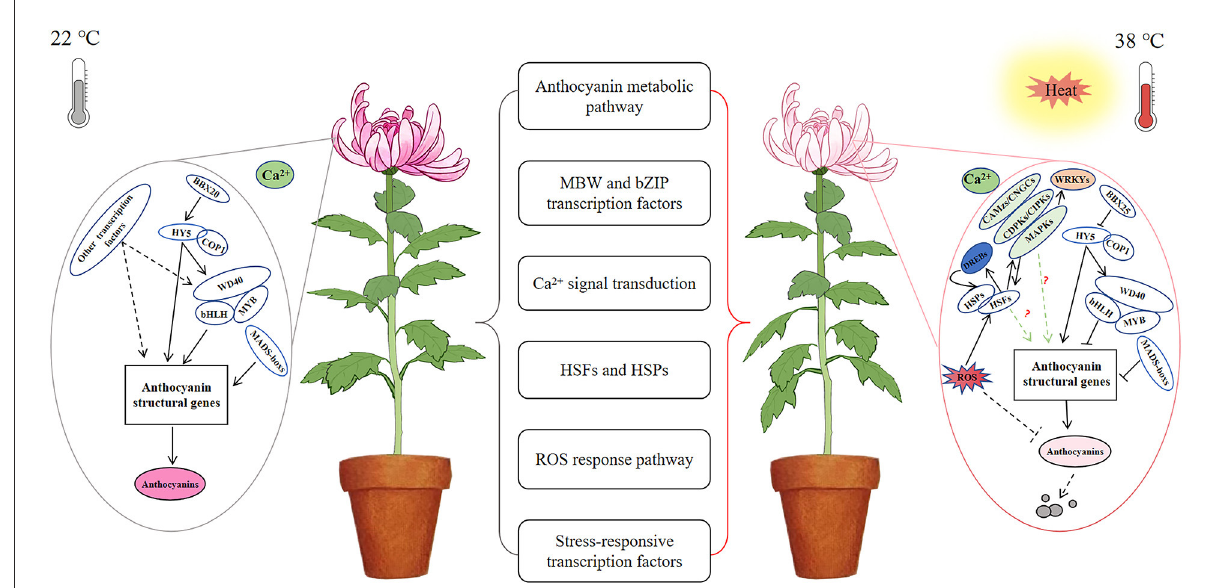
FIGURE8 A possible regulatory network of chrysanthemum flower color under high temperature stress. Anthocyanin biosynthesis was normal at 22 ◦ C; anthocyanin biosynthesis was inhibited and accelerated degradation under high temperature stress at 38 ◦ C.